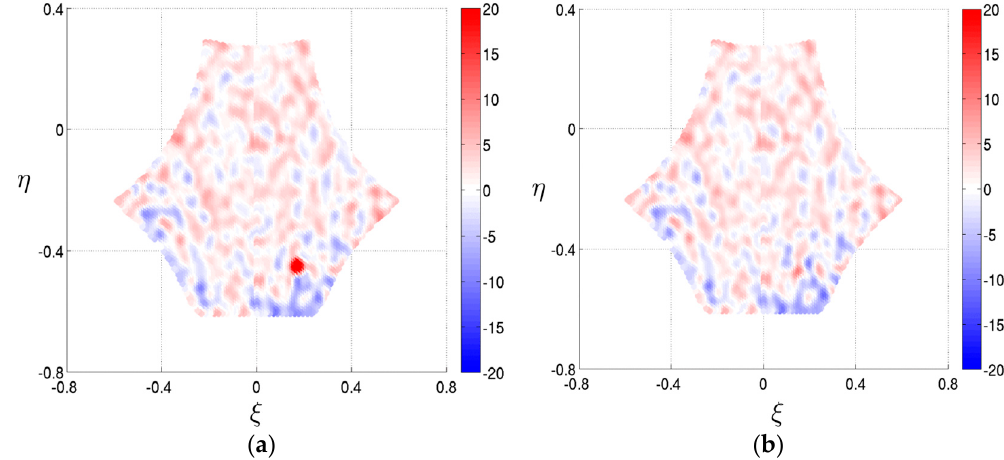
Figure 14. SMOS biases from a measurement in the Pacific after removing the expected forward model when the Sun is in the back of the instrument before ( a ) and after ( b ) the Sun BT correction in the back [18].